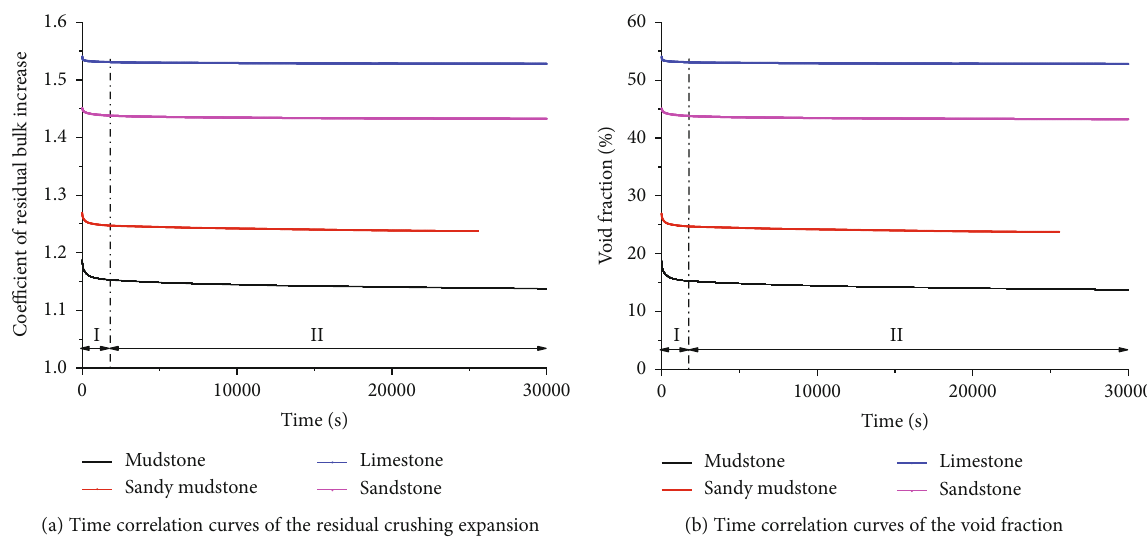
Figure 4: Time correlation curves of the amount of residual crushing expansion and void fraction for caving crushed rock samples of di ff erent lithology (axial stress of